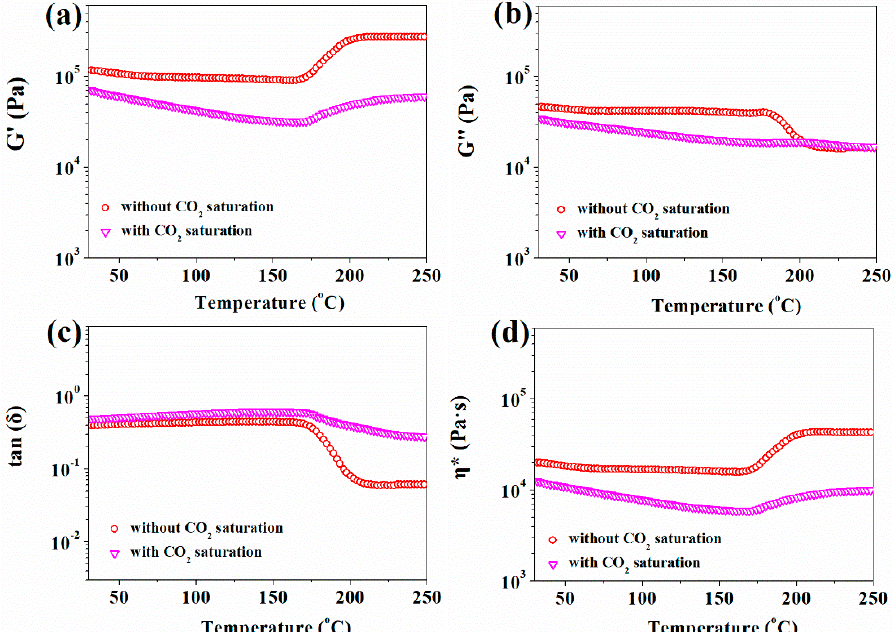
Figure 10. Temperature dependence of rheological properties of pre-vulcanized silicone rubber samples: ( a ) Storage modulus G’ ; ( b ) Loss modulus G’’ ; ( c ) Loss angle tan ( δ ); ( d ) Complex viscosity η * .